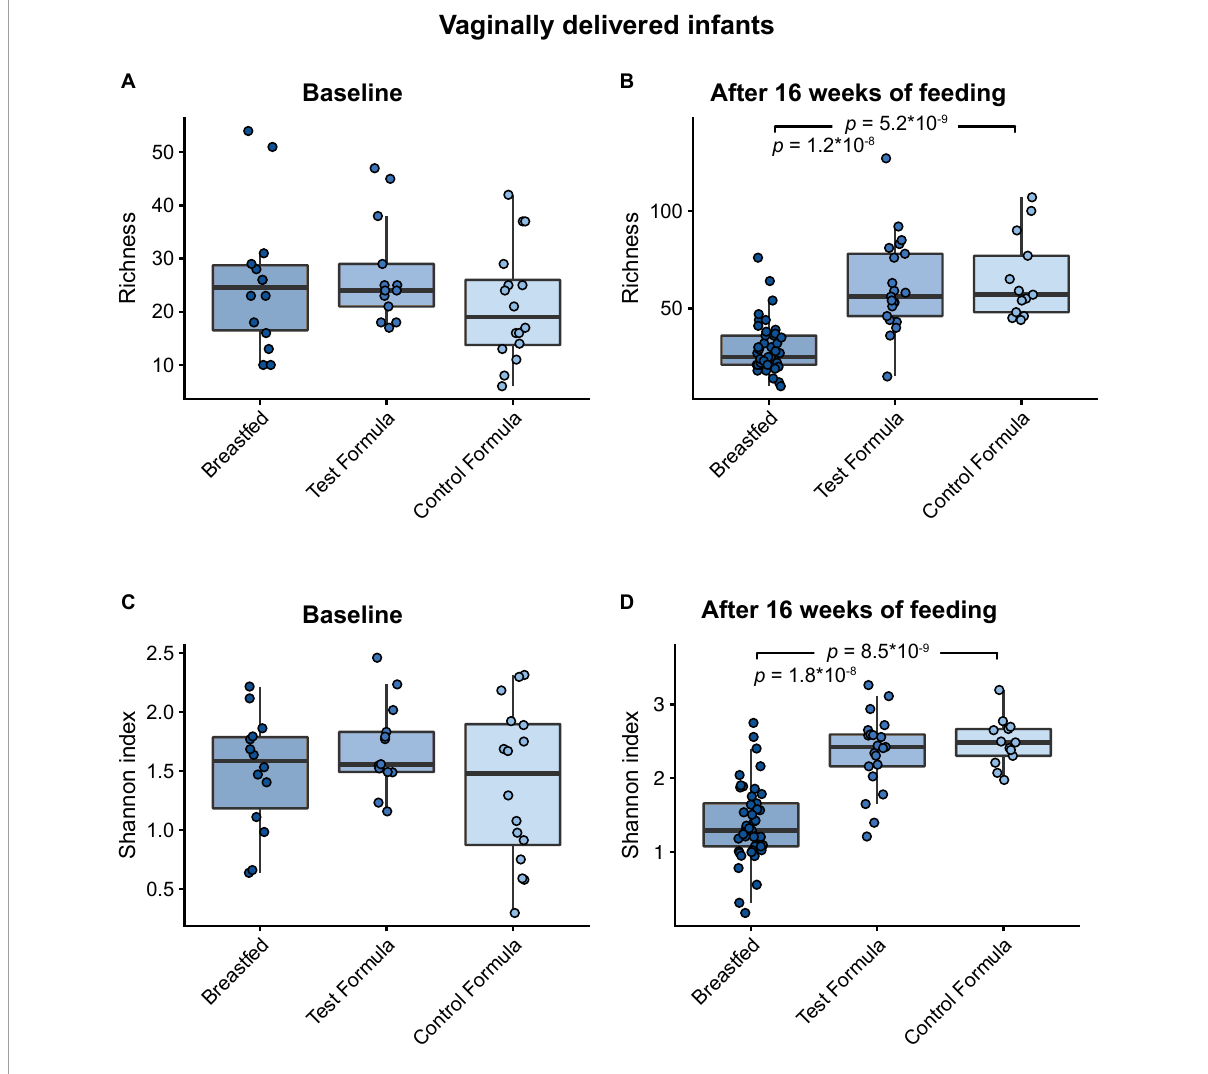
FIGURE2 Box plots of MGS richness and Shannon diversity index at baseline in vaginal delivered infants (A,B) and after 16 weeks of feeding in infants (C,D) in the breastfed, test formula, or control formula feeding group. Horizontal lines indicate the median; box boundaries indicate the interquartile range; whiskers represent values within 1.5 × the interquartile range of the first and third quartiles. Statistics: Mann–Whitney U -test. P -values < 0.05 are